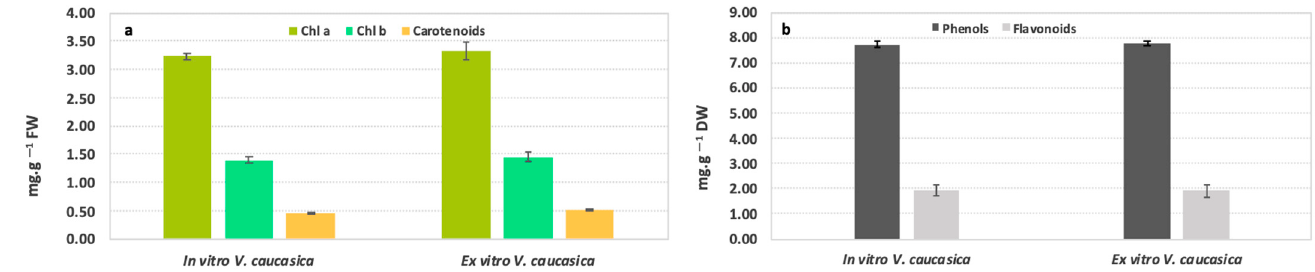
Figure 3. Comparative determination of some physiological indices in in vitro cultivated and ex vitro acclimated V. caucasica plants: plastid pigment content ( a ); total phenolic and flavonoid content ( b ). Data are presented as the mean ± SD.